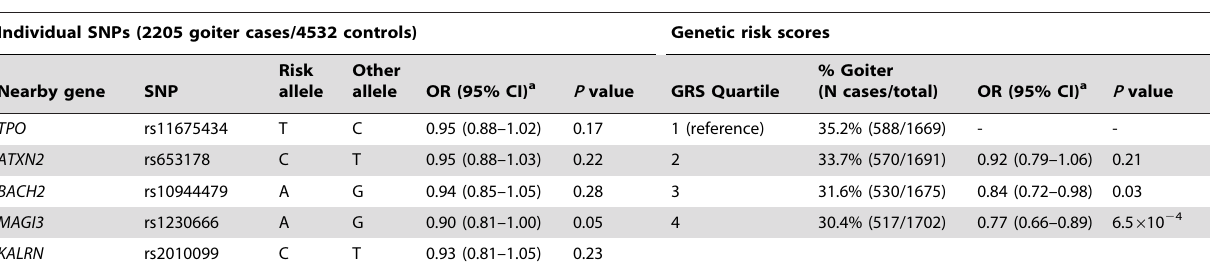
Table 5. Newly identified TPOAb associated loci, genetic risk scores and the risk of goiter.